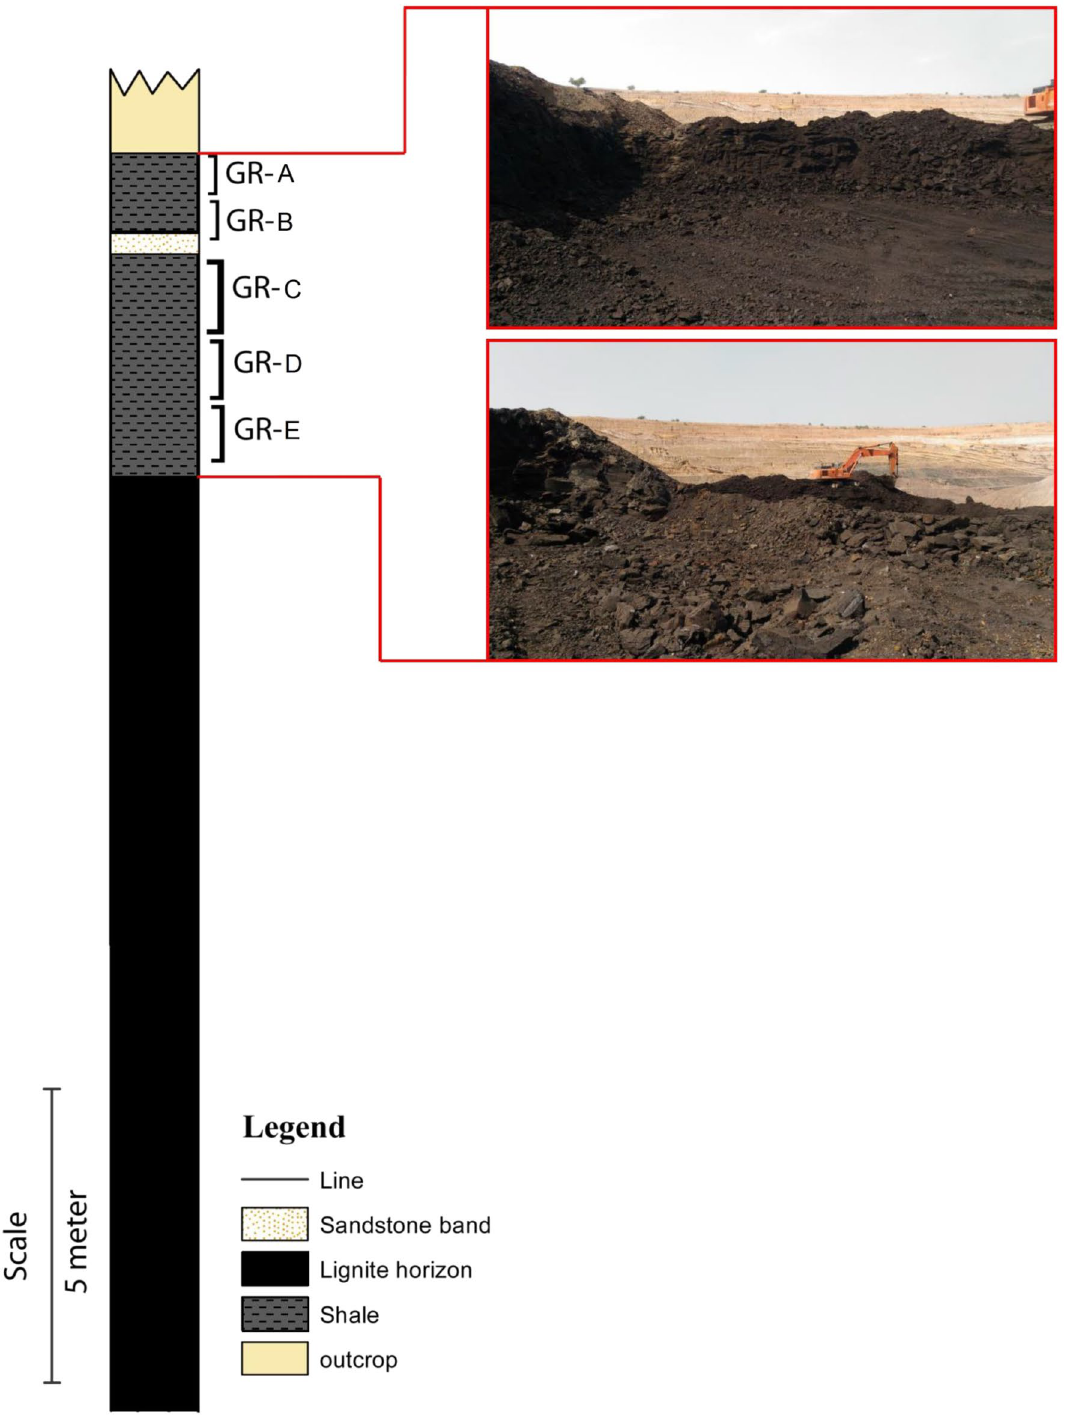
Figure 3. Lithology of the studied Gurha mine section, including the studied bituminous shale